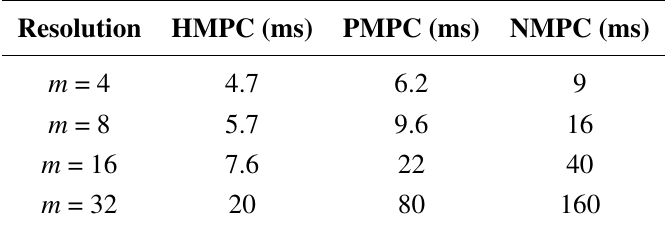
Table 2. Average computation time cost of the controller without the input constraint.